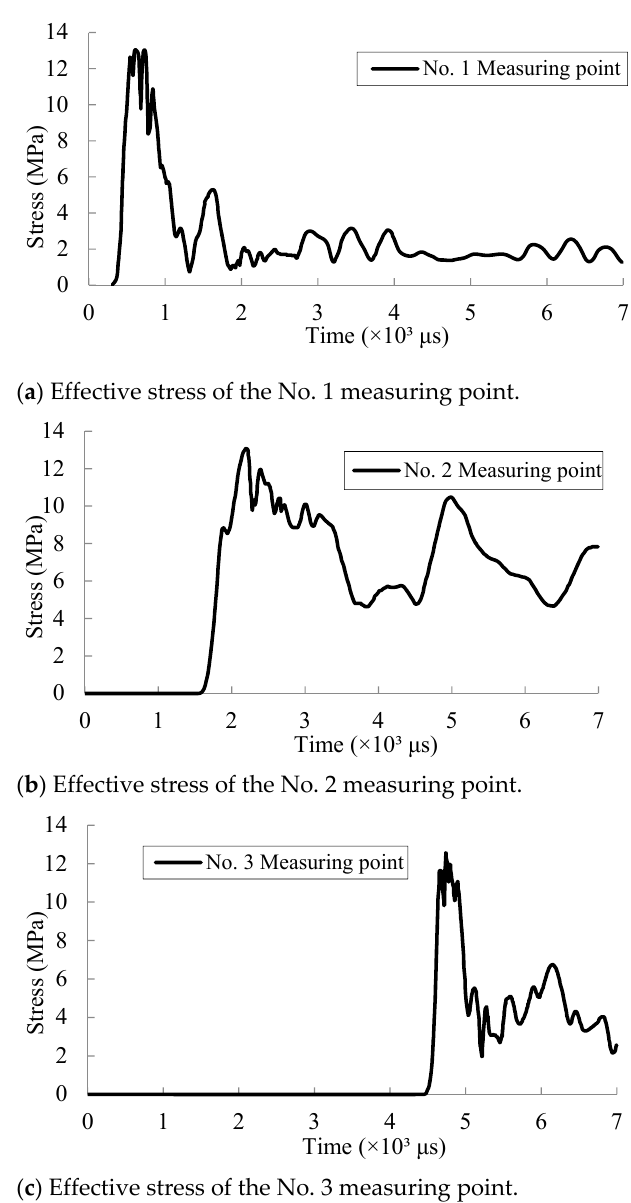
Figure 3. Effective stress curves of different positions to blast-holes: ( a ) effective stress of the No. 1 measuring point, ( b ) effective stress of the No. 2 measuring point, and ( c ) effective stress of the No. 3 measuring point.